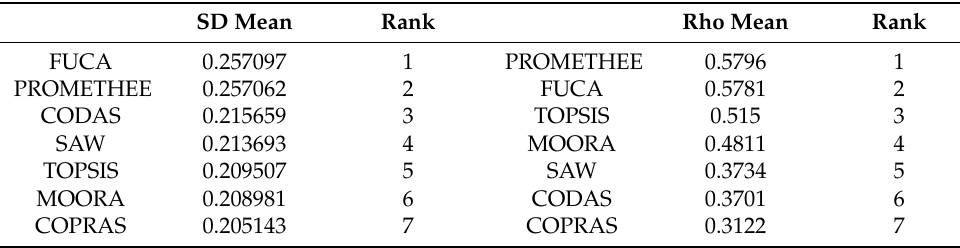
Table 11. Both SD and Rho Benchmark Findings.